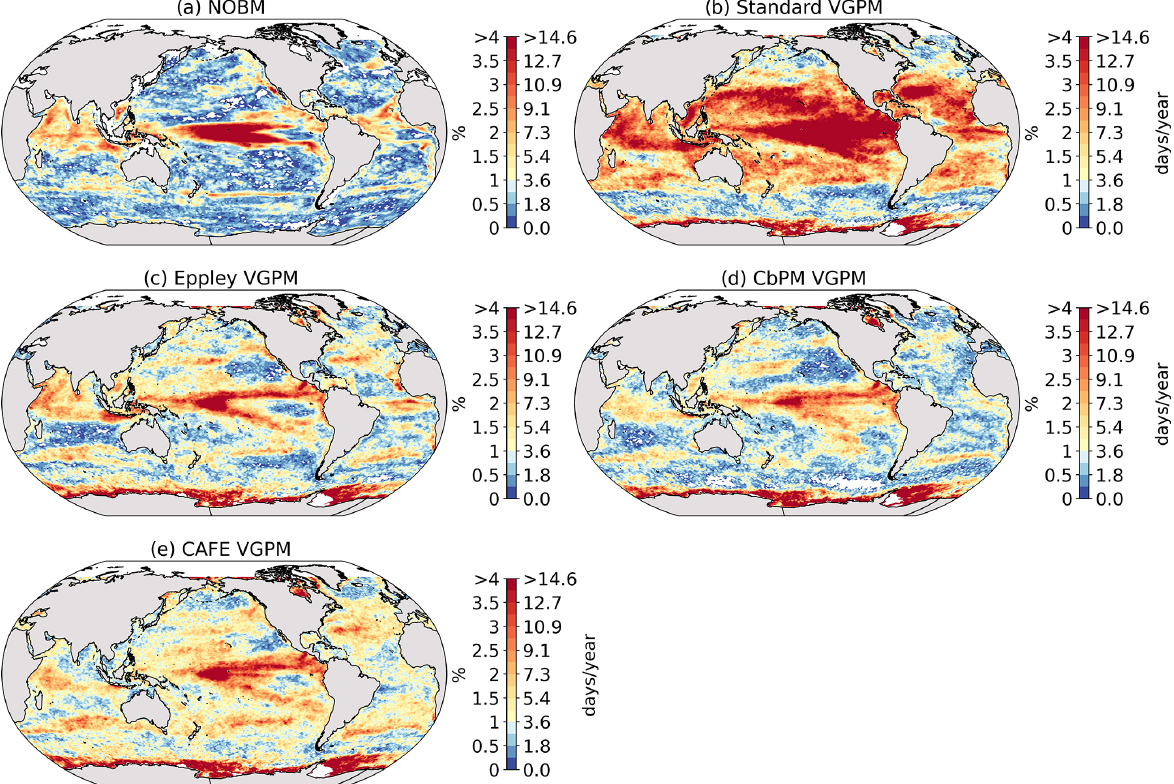
Figure B6. Likelihood (%) of compound MHW–NPPX events estimated using the observation-based NPP product of (a) NOBM, (b) Stan- dard VGPM, (c) Eppley-VGPM, (d) CbPM-VGPM, and (e) CAFE-VGPM.